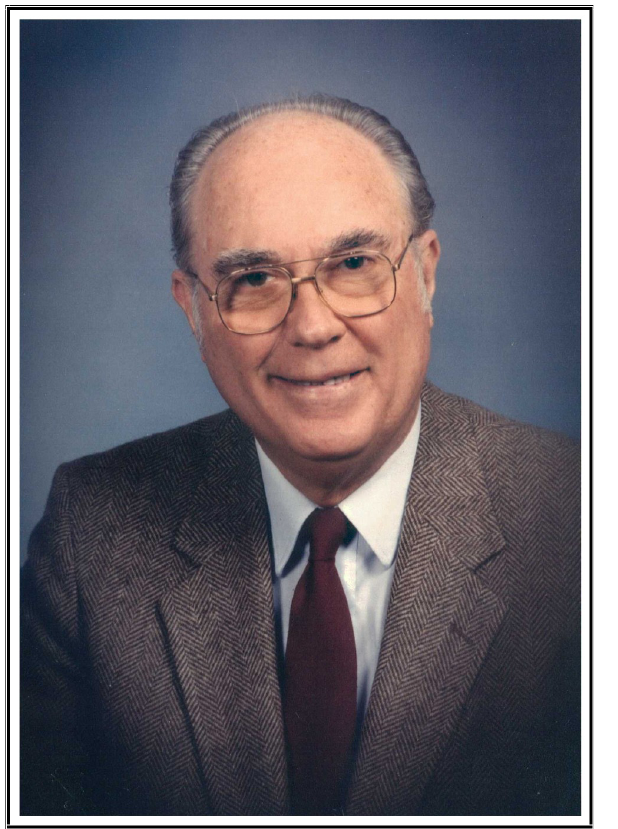
Figure 1. J. R. Underwood Jr., circa 1991. Credit: